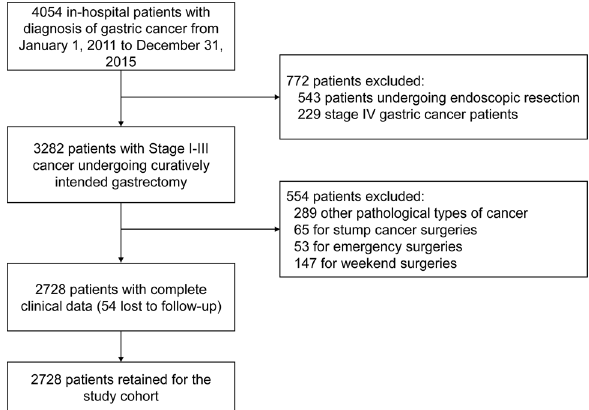
Figure 1. Flow chart of patient enrollment in this